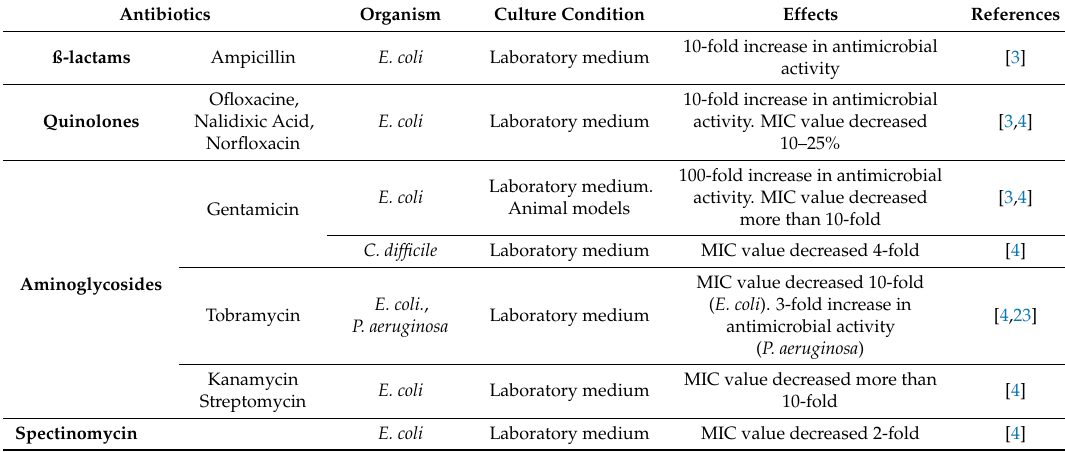
Table 1. Antibacterial activity of silver ions in combination with